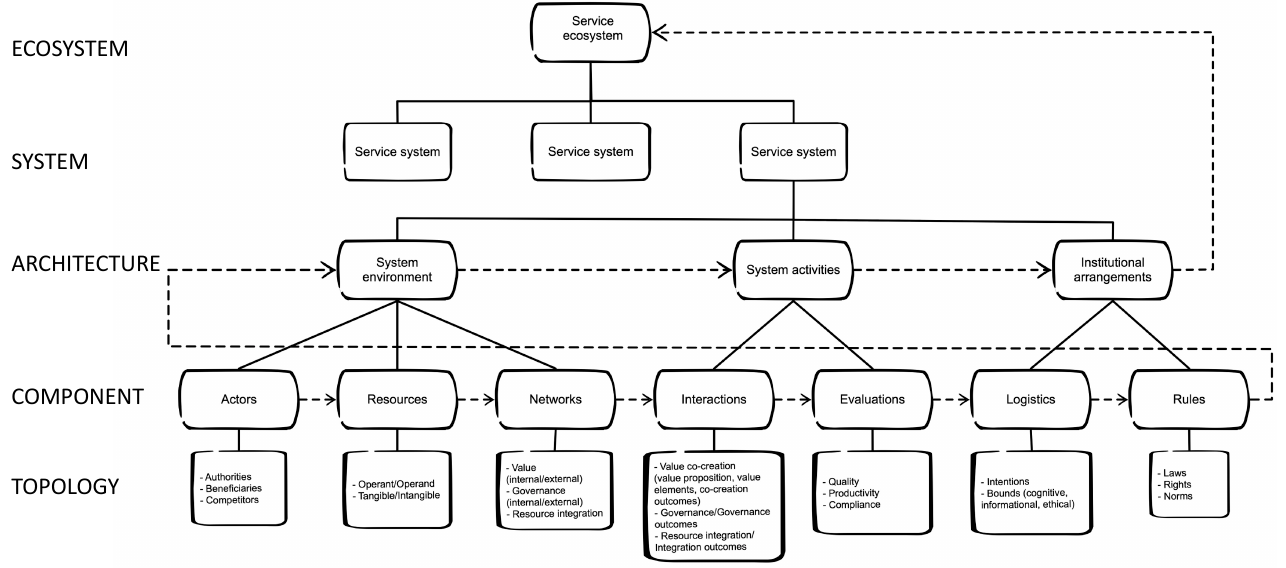
Figure 3. The multilayer service system framework (Frost et al. [74]).